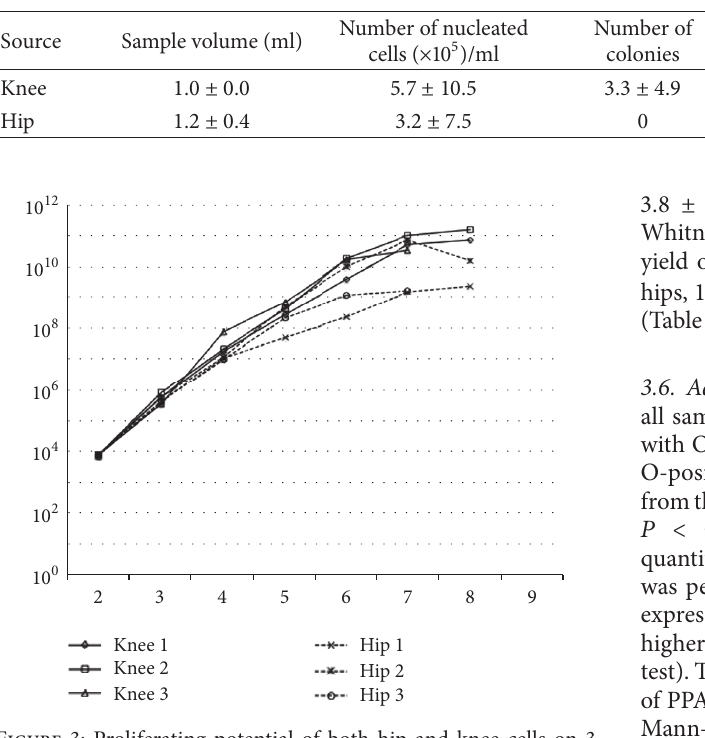
Figure 3: Proliferating potential of both hip and knee cells on 3 donors. Both passage-1 cells were plated at 50 cells/cm 2 on 150 cm 2 dishes. Thereafter, the cells were replated at 50 cells/cm 2 every 14 days until their expansion potential was lost. The expandabilities